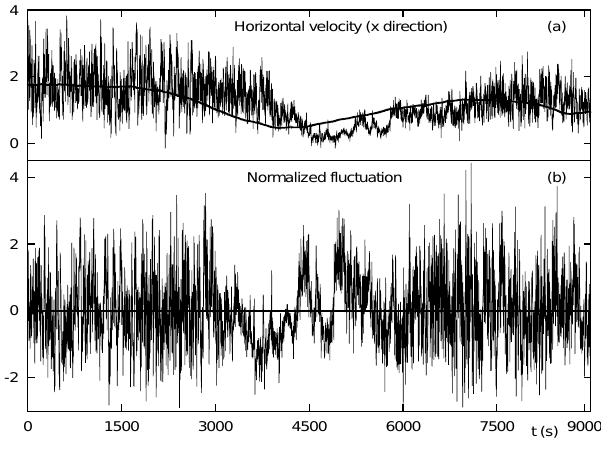
Fig. 1. Comparison of original signal and normalized fluctua- tion. (a) Sample from U x (t) time series and Moving Average U x (t) (thick line). (b) normalized fluctuation e U x (t) .